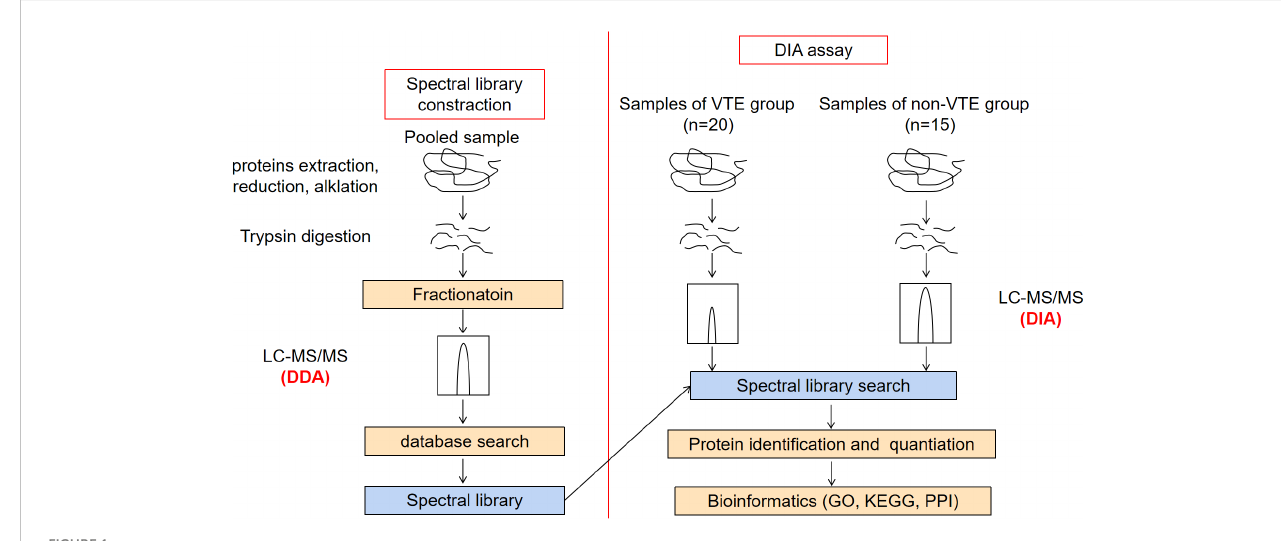
FIGURE 1 Flowchart of the